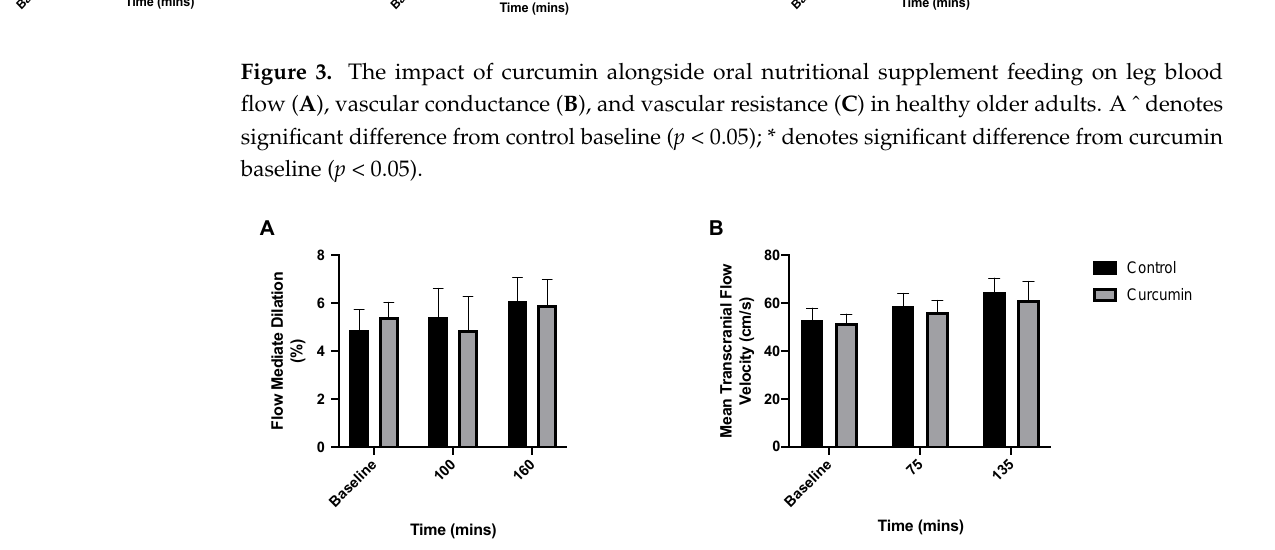
Figure 3. The impact of curcumin alongside oral nutritional supplement feeding on leg blood flow ( A ), vascular conductance ( B ), and vascular resistance ( C ) in healthy older adults. A ^ denotes sig- nificant difference from control baseline ( p < 0.05); * denotes significant difference from curcumin baseline ( p < 0.05).